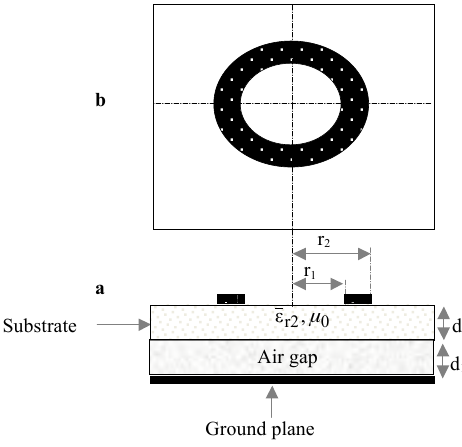
Figure 1: Geometry of a tunable microstrip ring